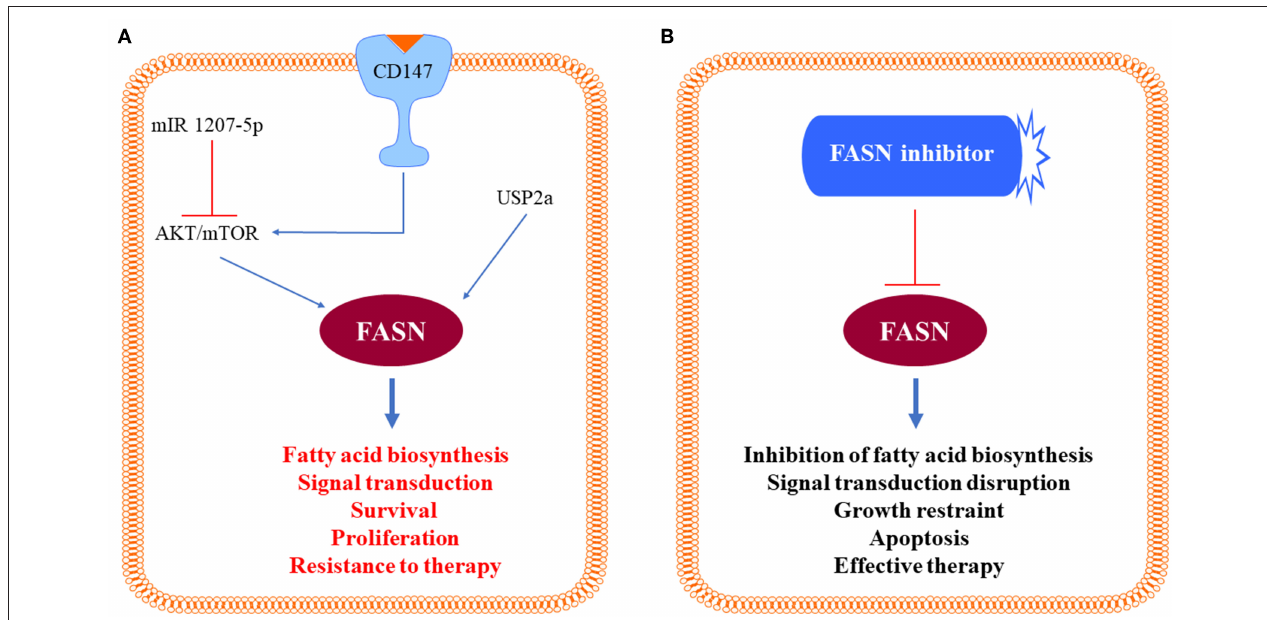
FIGURE 2 | Schematic representation of the identified molecular mechanisms triggering unrestrained fatty acid synthase (FASN) activity in hepatocellular carcinoma cells. (A) Positive signals inducing activation of the AKT/mTOR pathway (CD147) and loss of negative stimuli (mIR 1207-5p) toward the same pathway lead to activation of FASN and induction of its multiple, pro-oncogenic biologic effects, which are blunted by FASN inhibitors (B) . Further details are reported in the